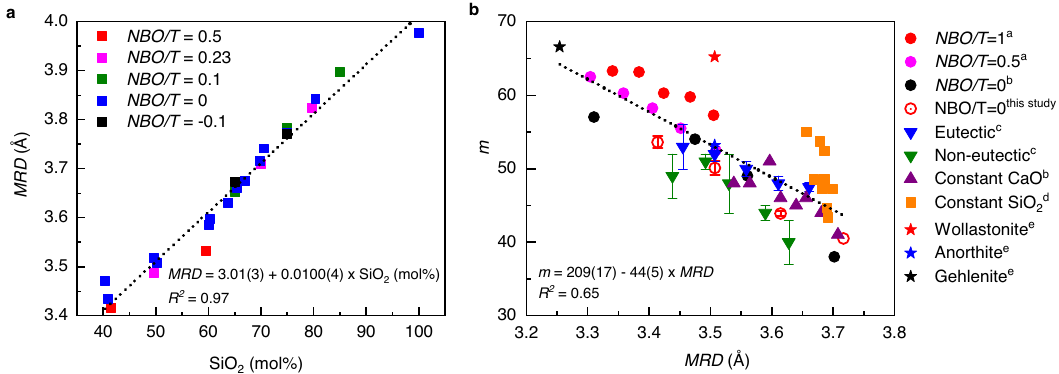
Fig. 2 | Linear correlationbetween MRD and SiO 2 mol% and inversecorrelation between fragility index ( m ) and MRD . In ( a ), 27 neutron-measured glasses with the same values of NBO / T ratio (de fi ned and listed in Supplementary Note 1 and Table2) are plotted with the same color.Glasses with similar SiO 2 mol%values but different NBO/T ratios are shown as clustered symbols with different colors, man- ifesting their similar MRD . The linear equation is derived by least-squares fi tting of the data for all glasses. The errors of both MRD (±0.01Å) and SiO 2 mol% (±0.1) values are smaller than the symbol size. In ( b ), MRD values of 48 CAS glasses are calculated by the linear equation obtained in ( a ). The glasses in each categorized